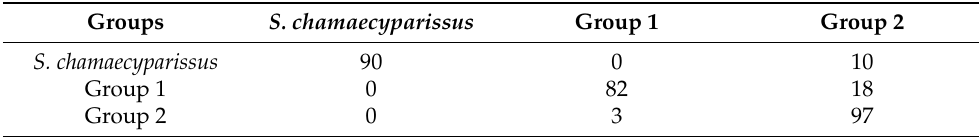
Table 9. Results of the Random Forest analysis applied to the groups of Corsican and Sardinian Santolina populations detected by the PCoA. Group 1 is composed of S. corsica from Mont Pigno (type locality) and S. insularis from Buggerru. Group 2 is composed of all the remaining populations (including the type locality of S. insularis ). Values are percentages.